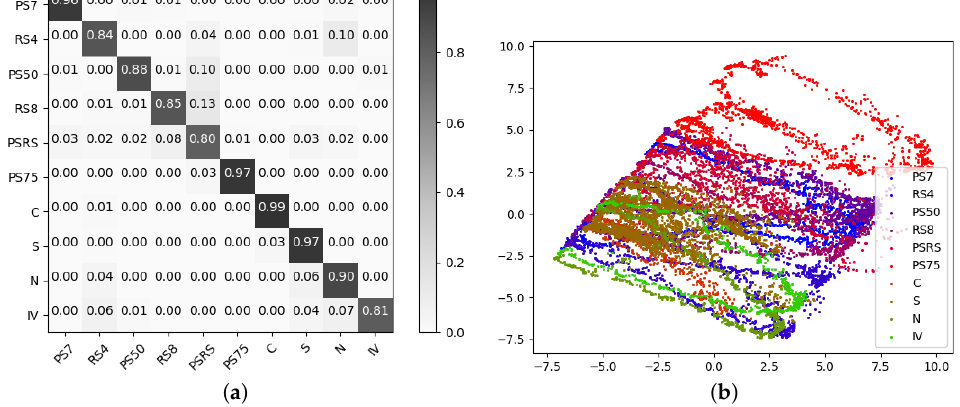
Figure 4. ( a ) Normalized confusion matrices for SDGM trained on the fully labeled complex dataset. ( b ) PCA (principal components 1 and 2) on the latent